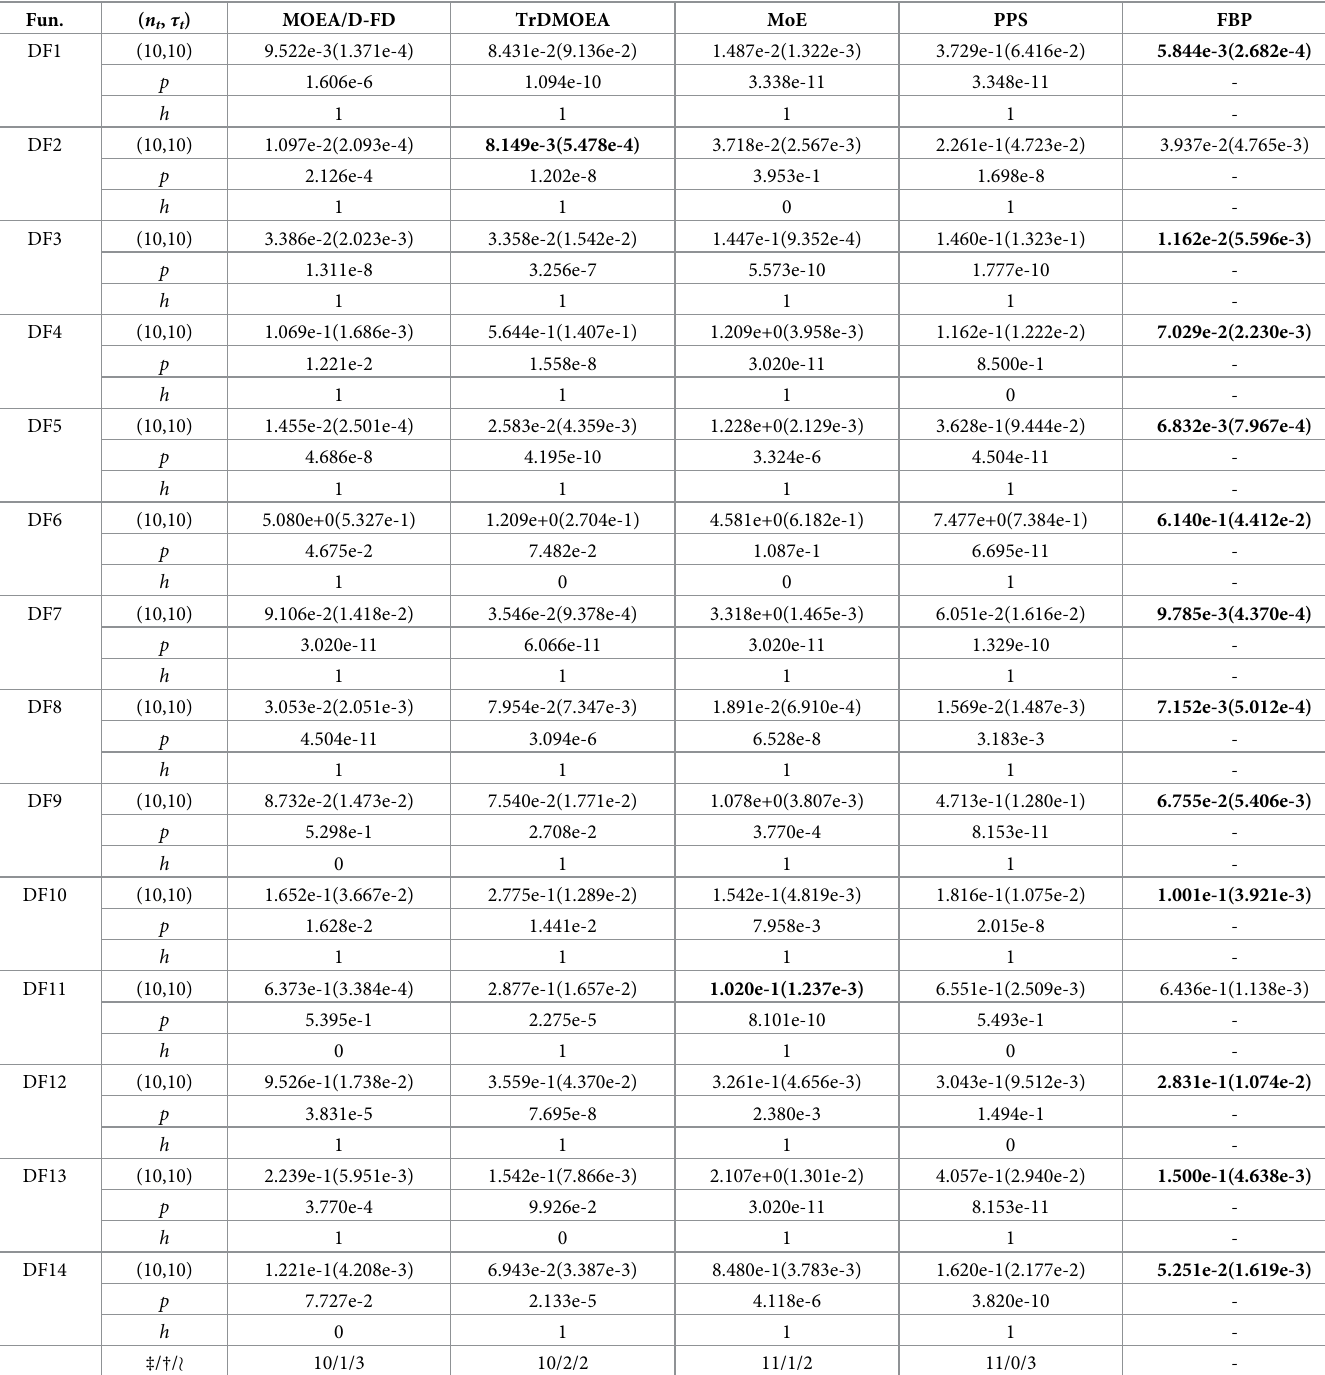
Table 2. Mean and standard deviation values of MIGD obtained by five algorithm for ( n t , τ t ) = (10,10).